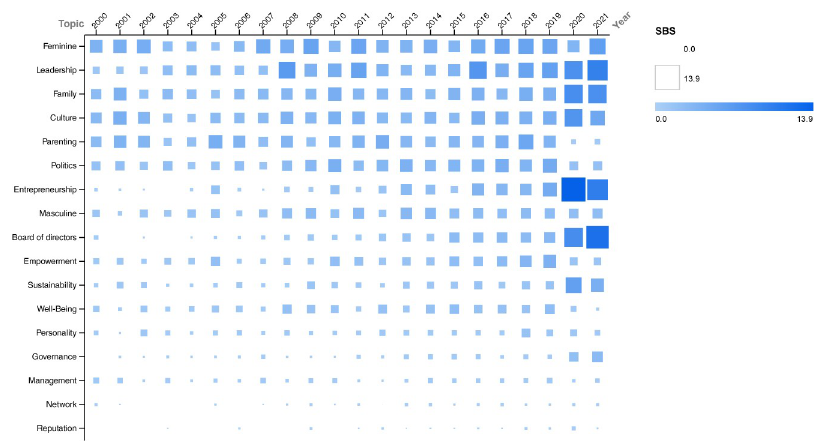
Fig 3. SBS time series of the other topics.